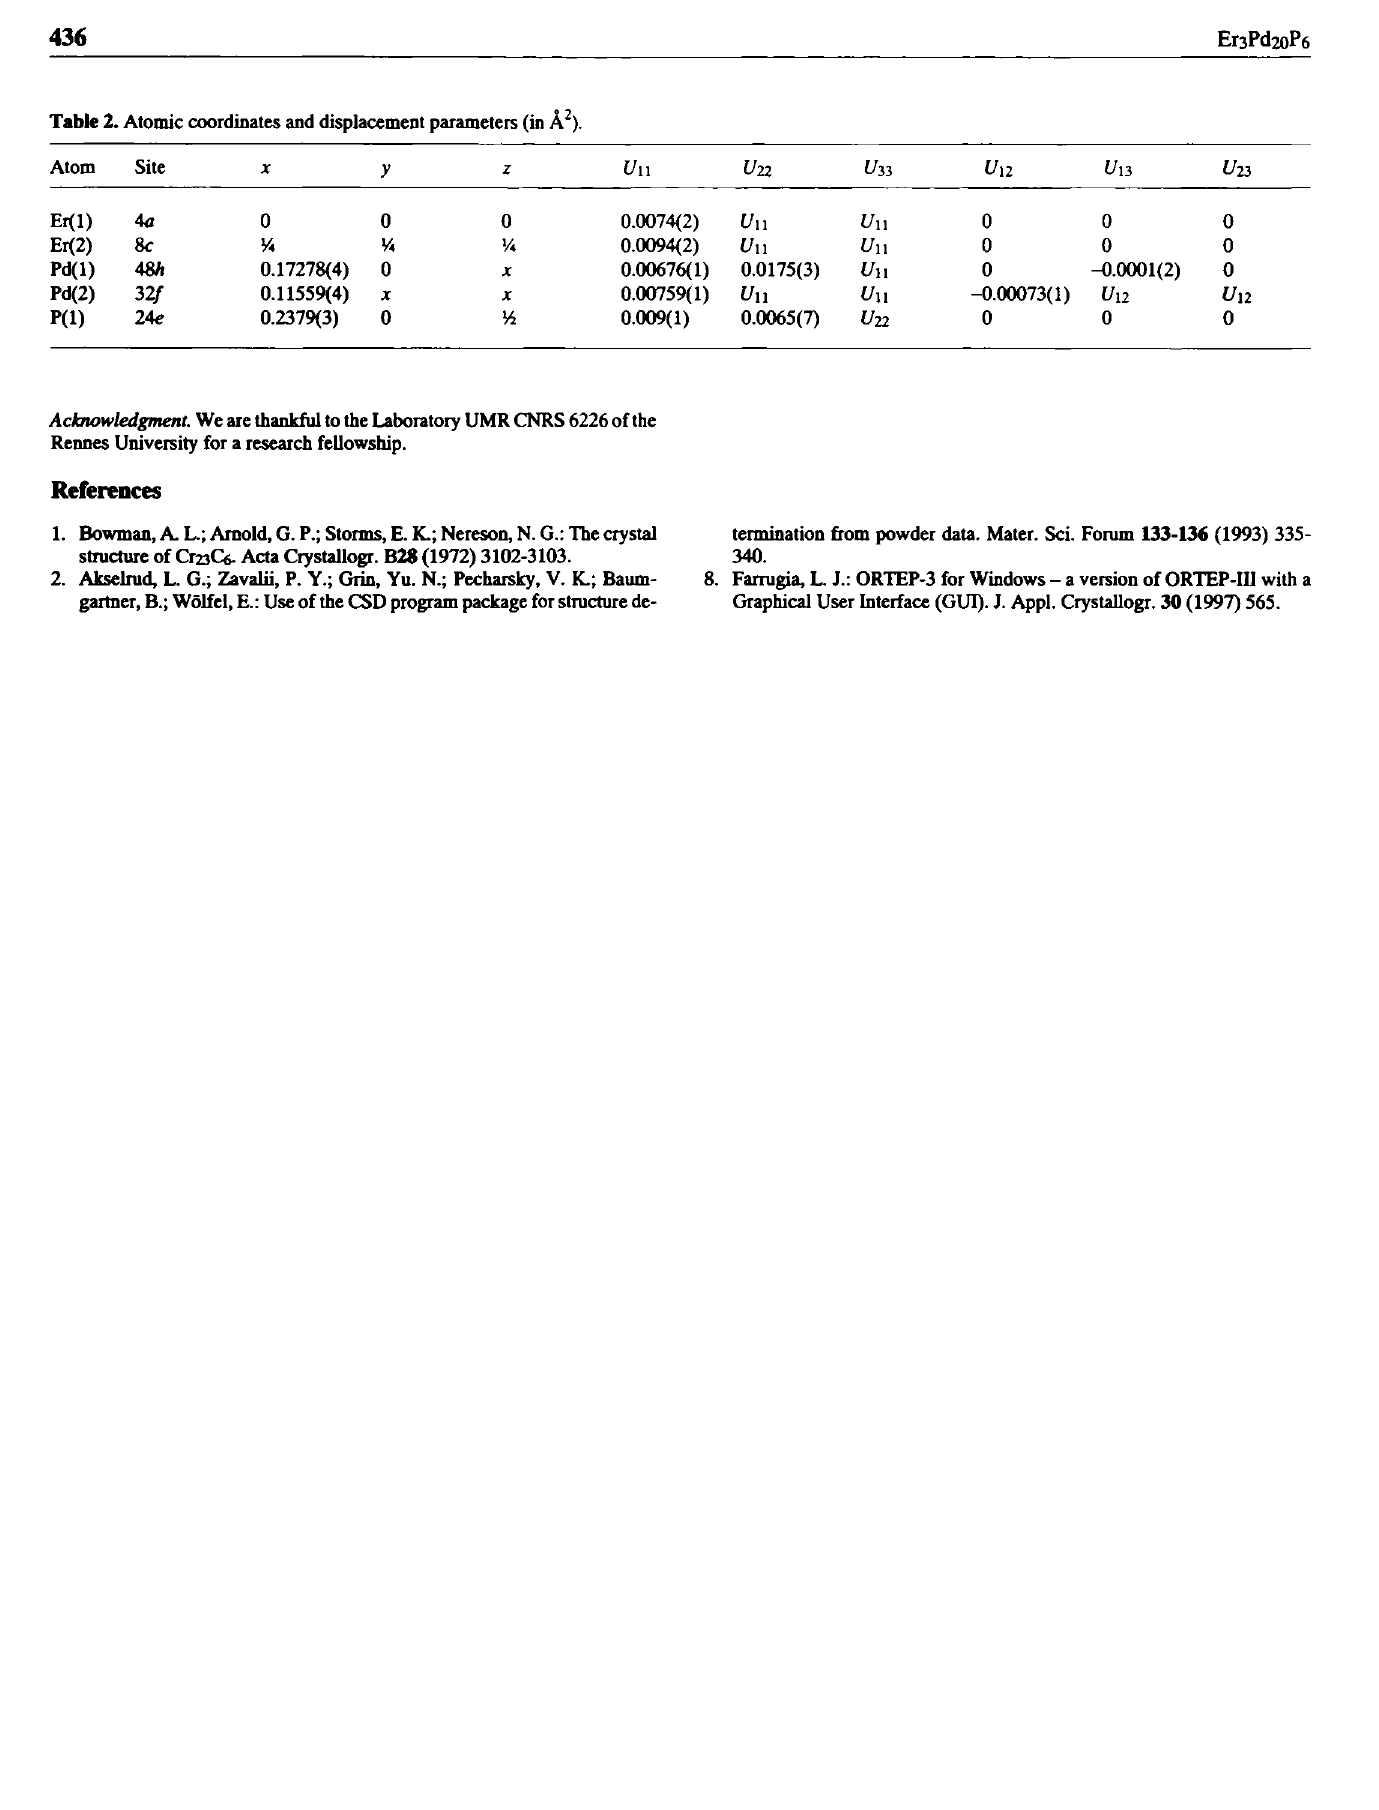
Table 2. Atomic coordinates and displacement parameters (in A 2